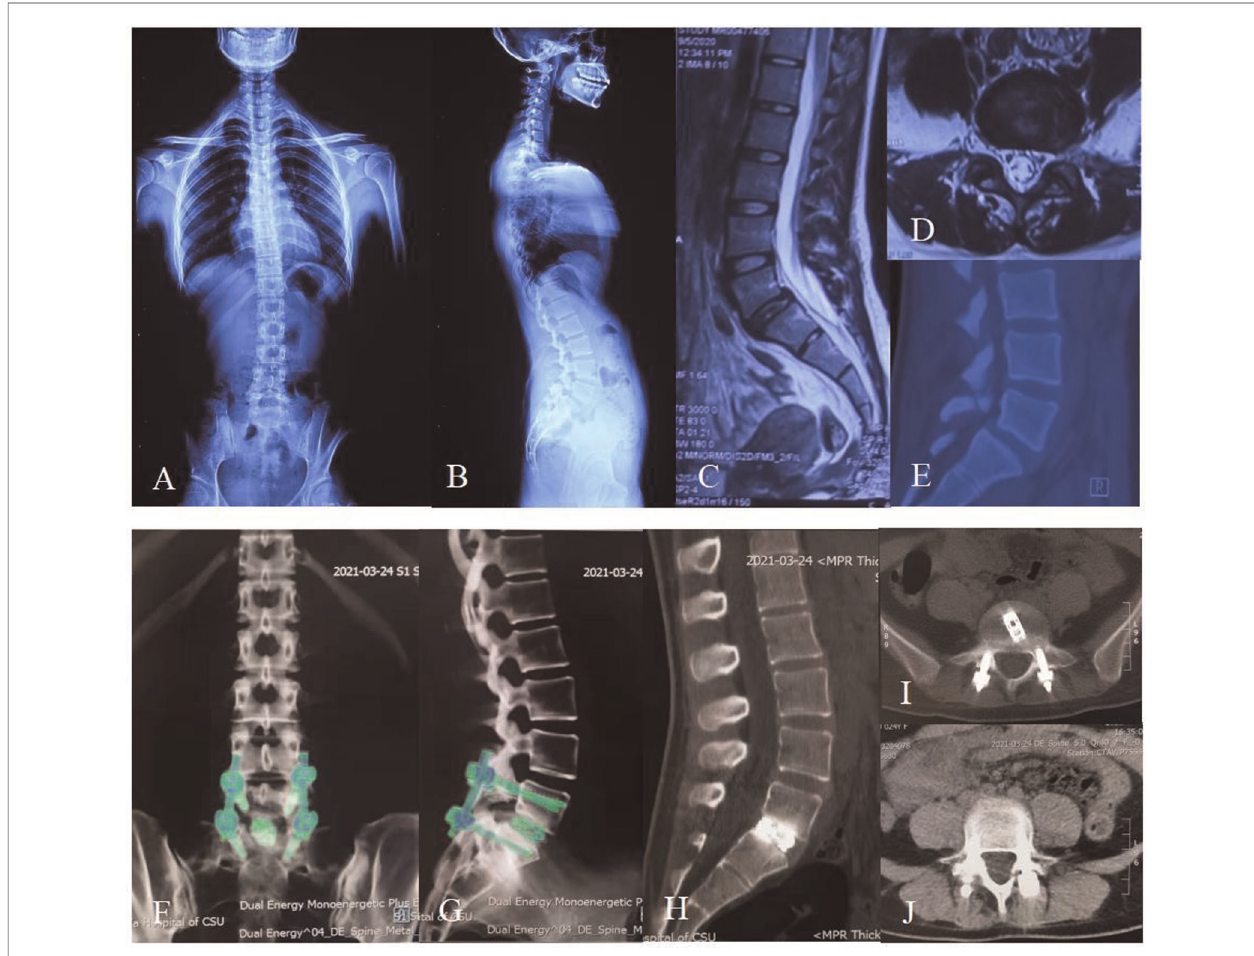
FIGURE 3 | Twenty-four-year-old female with 10-month lumbar pain and half-month left leg pain. ( A , B ) Preoperative X-ray showing the patient had a degenerative L5/S1 spondylolisthesis up to Grade I according to the Meyerding standard and had a slightly degenerative lumbar scoliosis. ( C ) Preoperative sagittal MRI showing the patient had an L5/S1 spondylolisthesis and multi-level disc degeneration. ( D ) Preoperative cross-sectional MRI showing that the spondylolisthesis in L5/S1 led to a stenosis of left lateral recess. ( E ) Preoperative sagittal CT showing an isthmus fi ssure in L5 and spondylolisthesis in L5/S1. ( F , G ) The postoperative dual energy CT showing that the cage and pedicle screws were complete and in position at the follow-up of 6 months after surgery. ( H – J ) The postoperative CT showing a sign of fusion within the interbody of L5/S1 at the follow-up of 9 months after surgery, and the fi xation instruments were complete and in